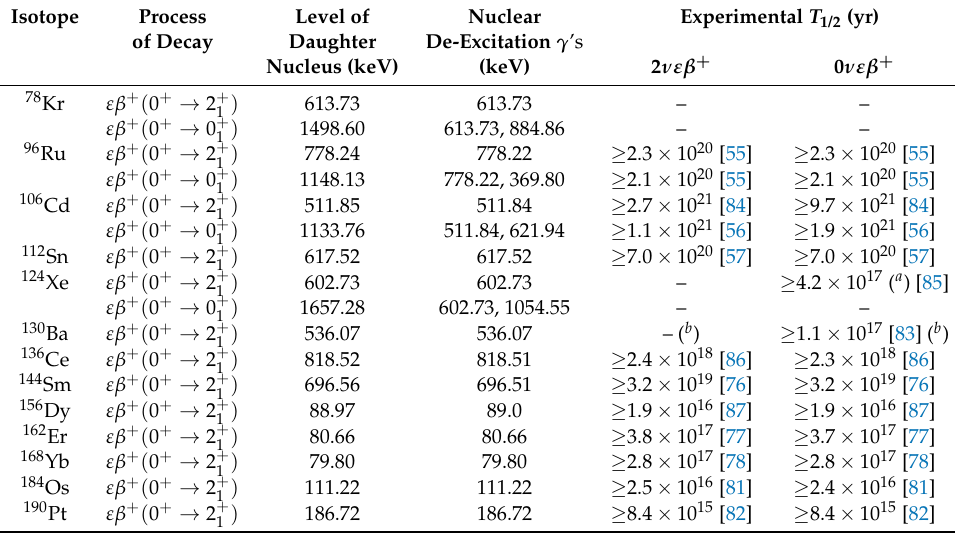
Table 6. Some of the isotopes most considered in the field of the εβ + decay (2 ν and 0 ν ) to the excited levels of daughter nuclei. When available, the present best experimental result on T 1/2 is also reported (limits are at 90% C.L.). Only the transitions to the first 2 + and 0 + excited levels of the daughter nucleus, if energetically allowed, are considered. See